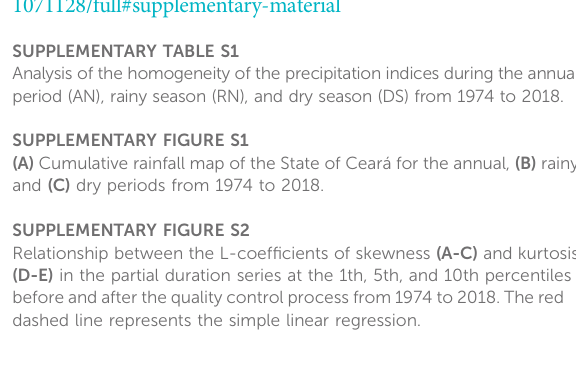
period (AN), rainy season (RN), and dry season (DS) from 1974 to 2018. SUPPLEMENTARY FIGURE S1 (A) Cumulative rainfall map of the State of Ceará for the annual, (B) rainy and (C) dry periods from 1974 to 2018. SUPPLEMENTARY FIGURE S2 Relationship between the L-coef fi cients of skewness (A-C) and kurtosis (D-E) in the partial duration series at the 1th, 5th, and 10th percentiles before and after the quality control process from 1974 to 2018. The red dashed line represents the simple linear